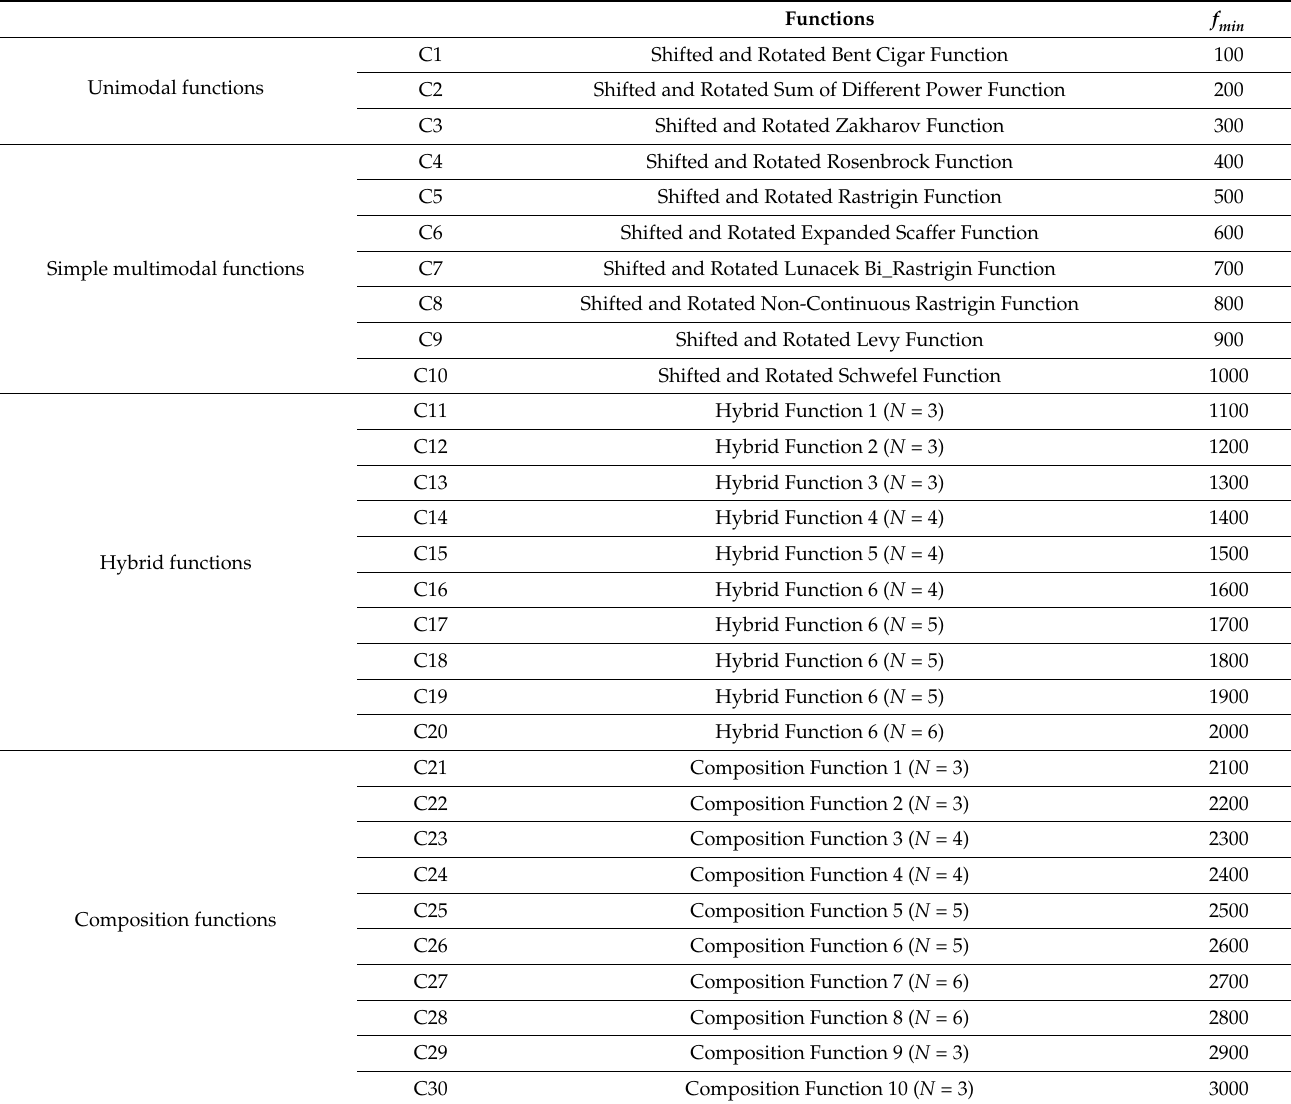
Table A4. Information of CEC 2017 test